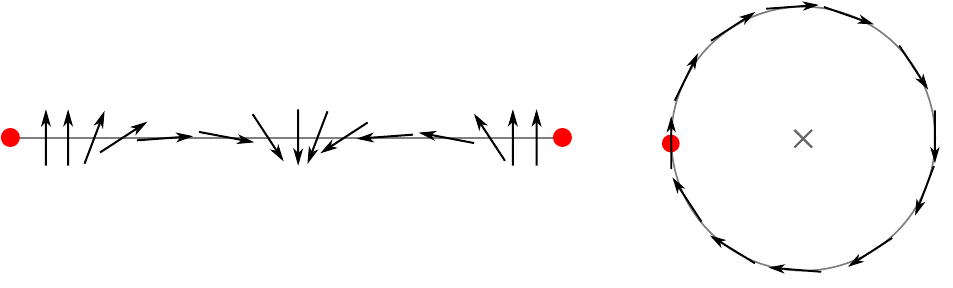
Figure 6.5: A topological soliton of charge one. Left: the configuration in real space, on a finite line. The spins at the boundaries (red dots) point in the same direction. As the line is traversed from left to right, the spins wind smoothly over a 2 π angle. Right: the (red) points at the boundary of the line are mapped to the same point on a circle, illustrating the topological nature of the soliton. The cross indicates the position of the associated singularity, which lies outside of the one-dimensional space on which the order parameter field is